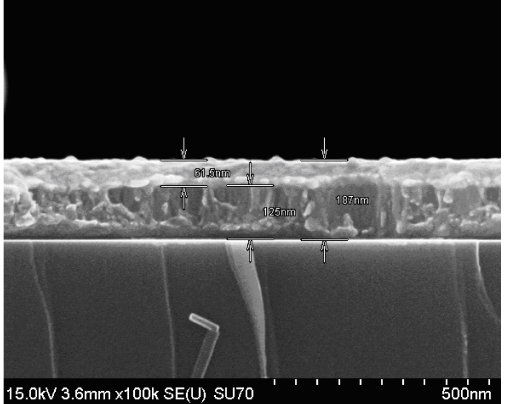
Figure 13. Software analysis of the SEM cross-section image reported in Sharp et al. reveals that the thickness of the Au film is 60.1nm with a 123.5nm-thick Ni film underneath a Si substrate, both with a claimed resolution of less than 1nm; although that resolution may vary depending on the degree of contrast between subsequent layers. (Reprinted from [34], Copyright Cambridge University Press,